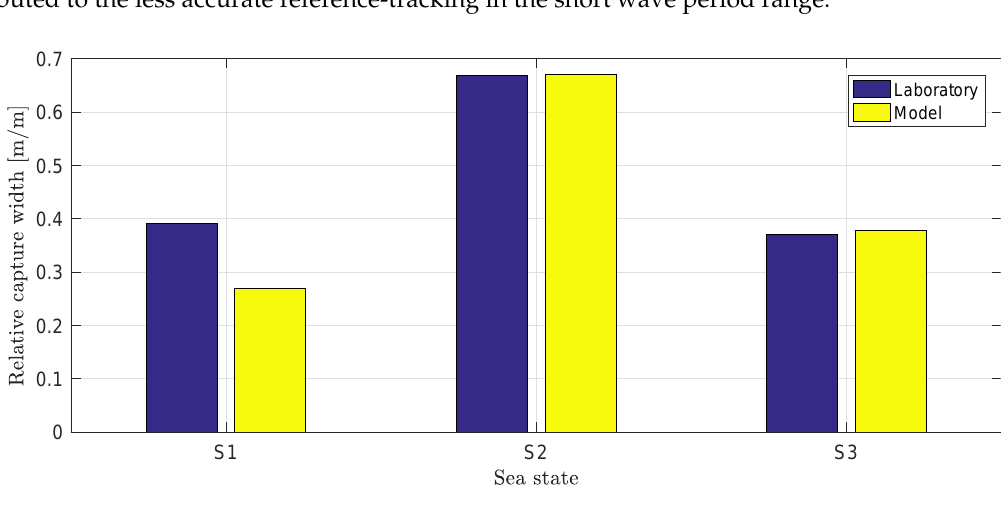
Figure 18. Average absorption width in irregular wave sea states, where experimental data is compared to results from the mathematical model for Setup 5. Blue: Experimentally determined relative capture width. Yellow: Capture width determined from simulation